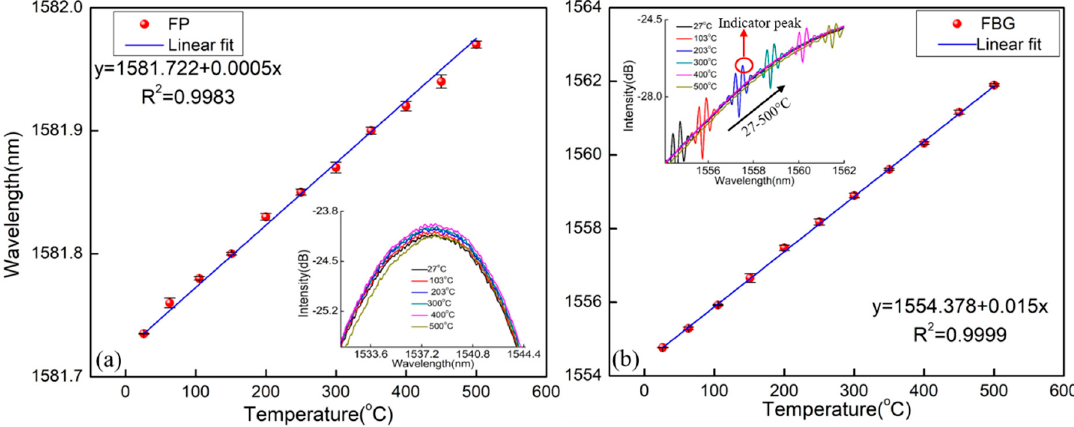
Figure 4. Temperature response of the sensor. ( a ) The FP; ( b ) the FBG.